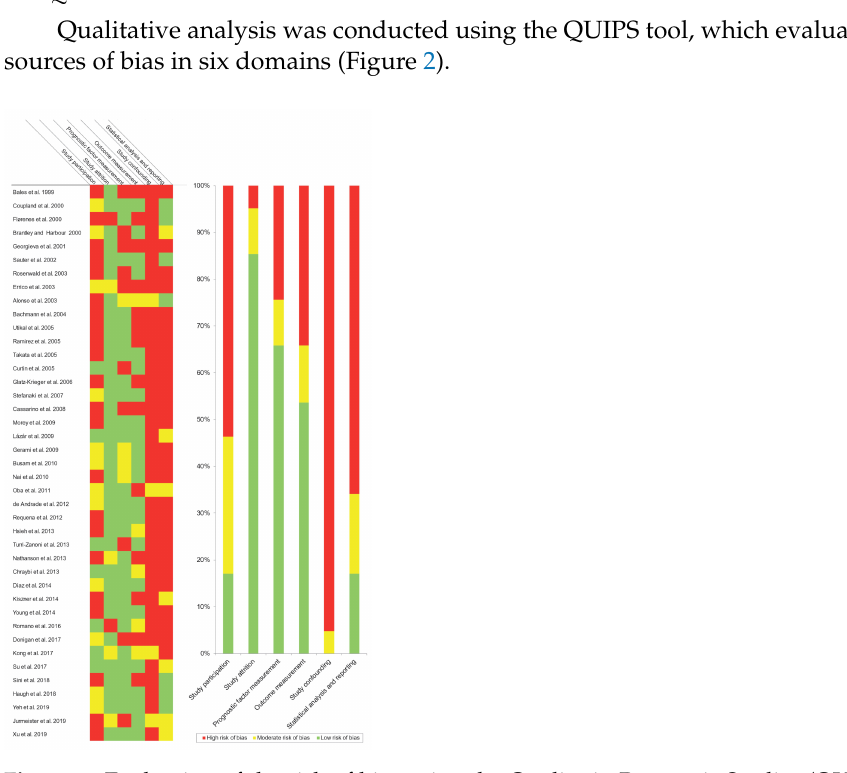
Figure 2. Evaluation of the risk of bias using the Quality in Prognosis Studies (QUIPS) tool (the references cited in this figure are listed in Supplementary